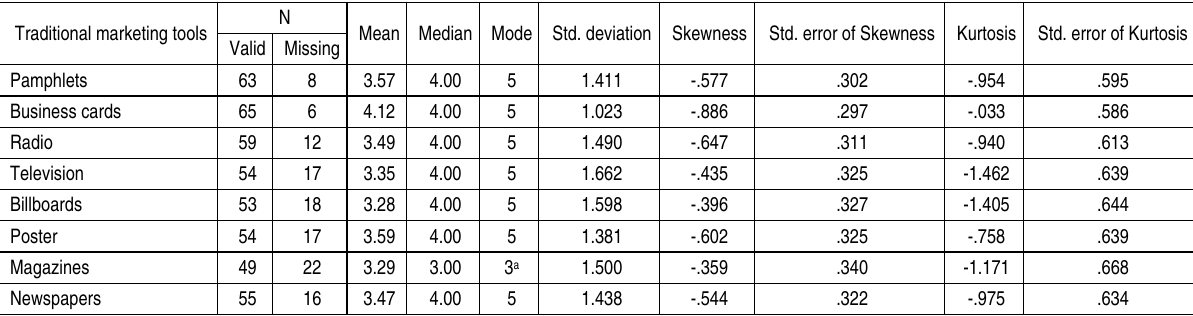
Table 3. Descriptive statistics for the questions on the effectiveness of use of marketing tools Traditional marketing